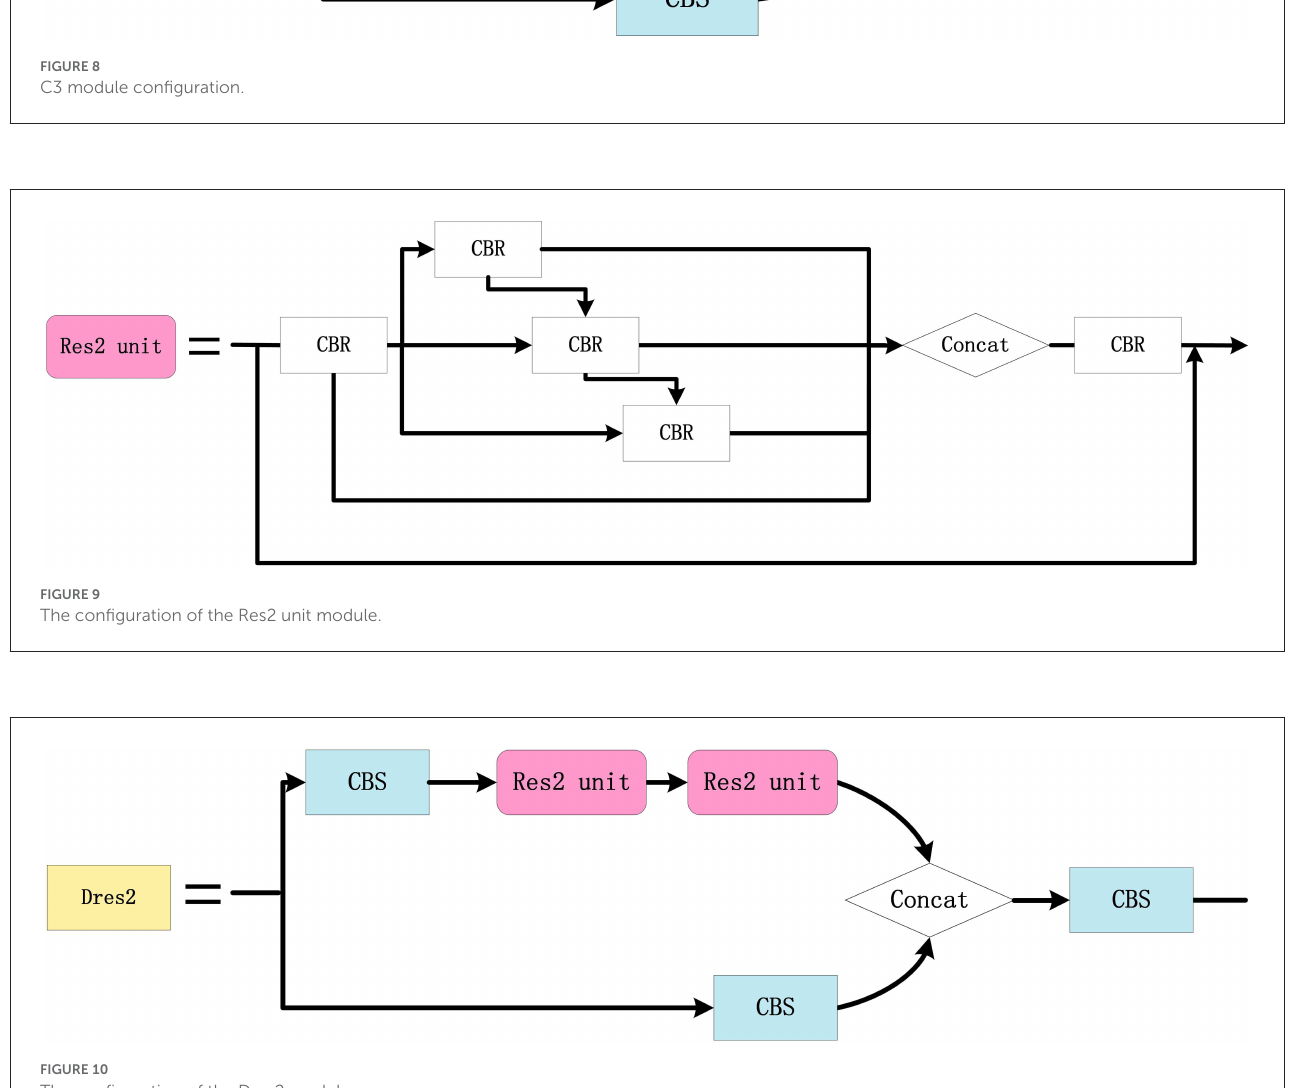
FIGURE10 The configuration of the Dres2